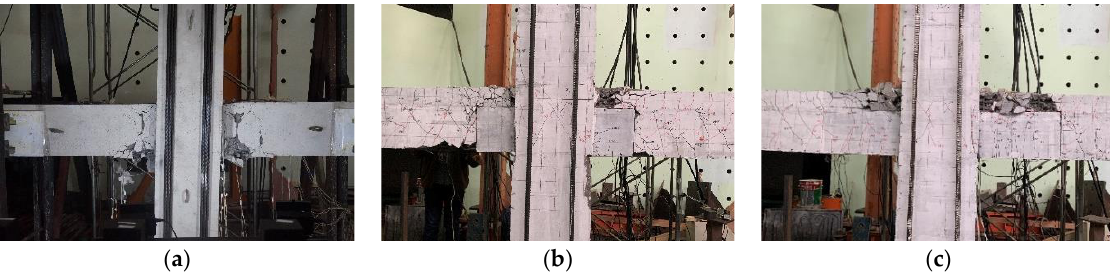
Figure 6. Failure modes of specimens. ( a ) S1 , ( b ) PU1, ( c ) PU2.